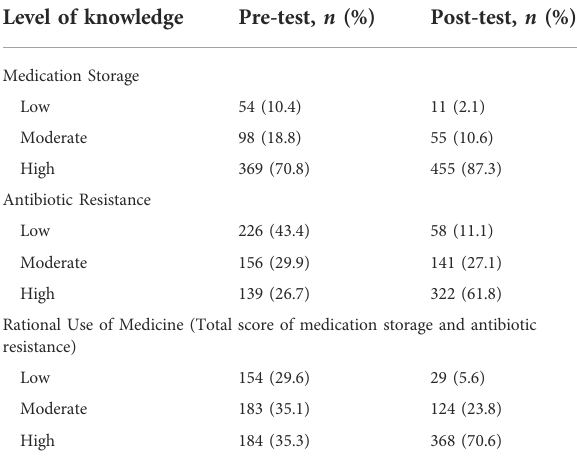
TABLE 4 Level of participants ’ knowledge on medication storage, antibiotic resistance and rational use of medicine.